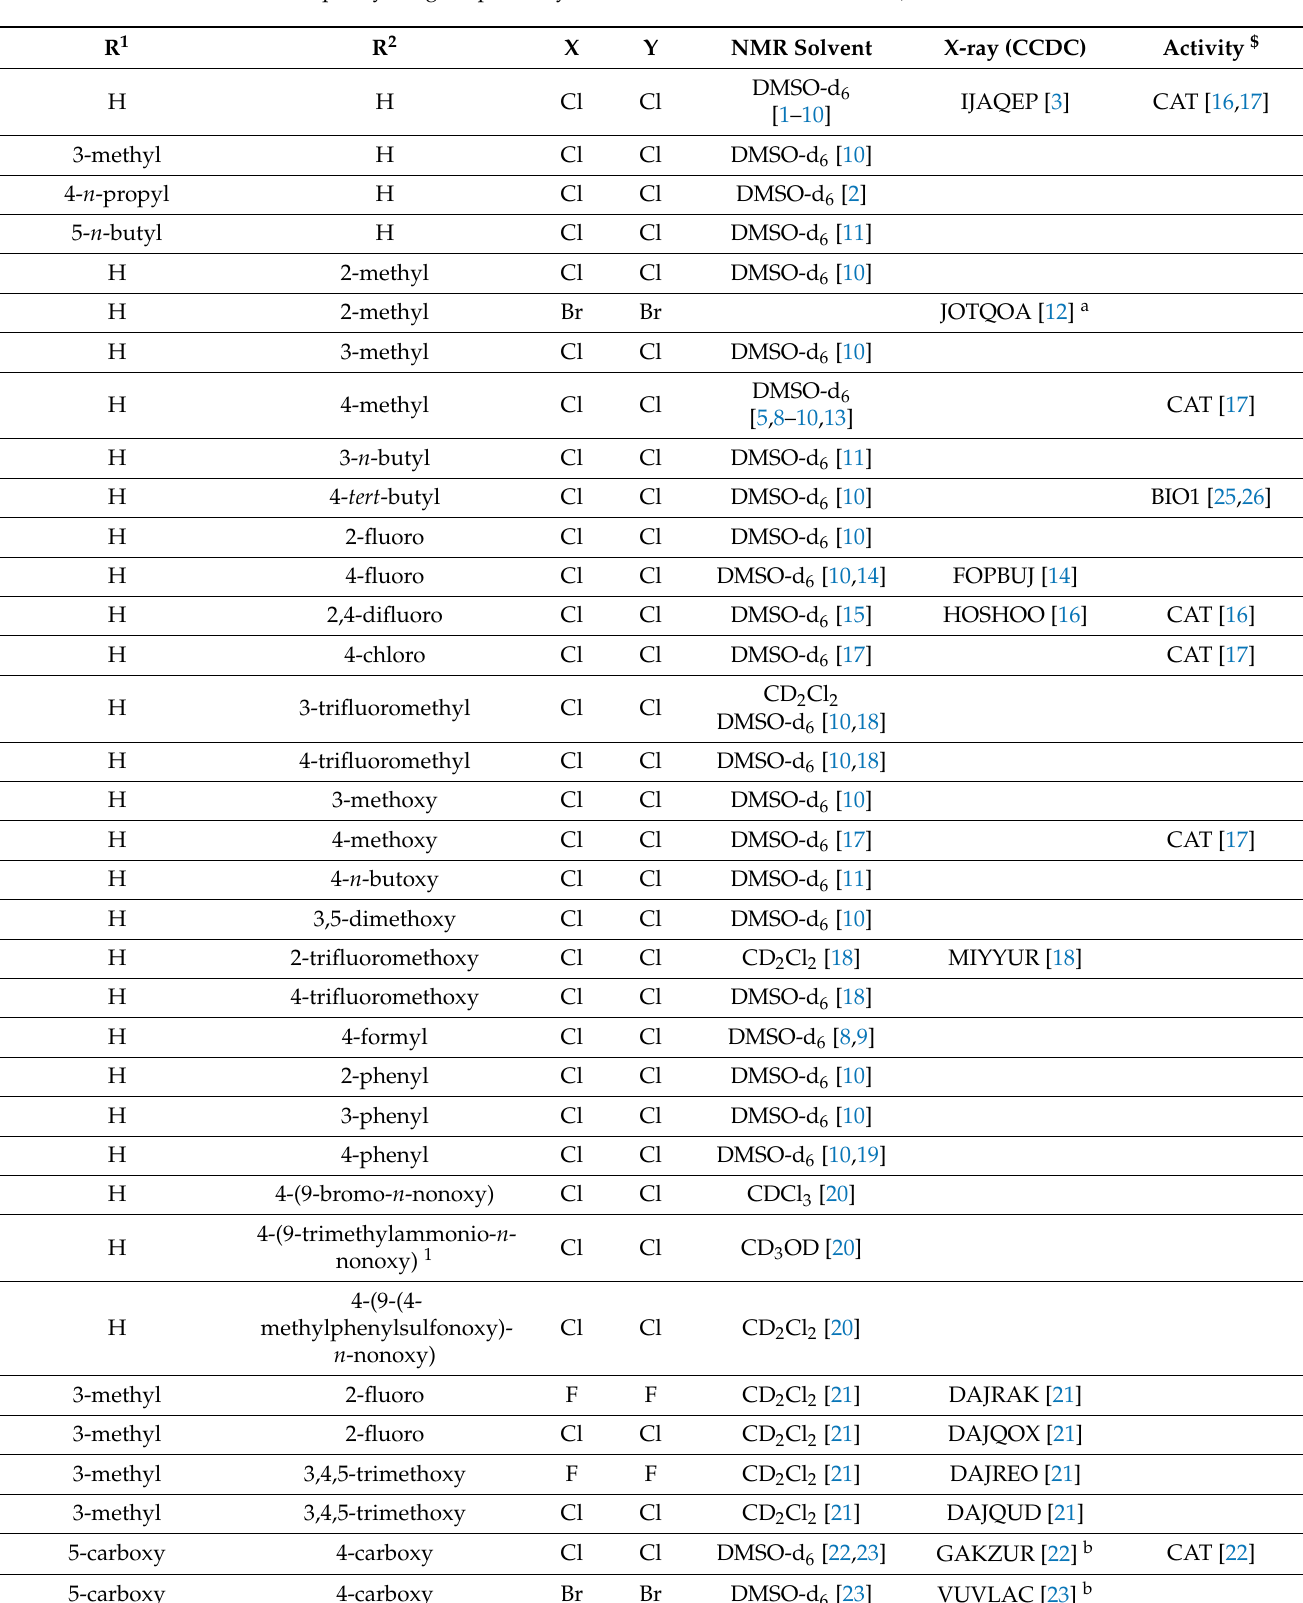
Table 1. NMR and/or X-ray studied [Au(2PPY*)XY] (in particular, [Au(2PPY*)X 2 ]) dihalides